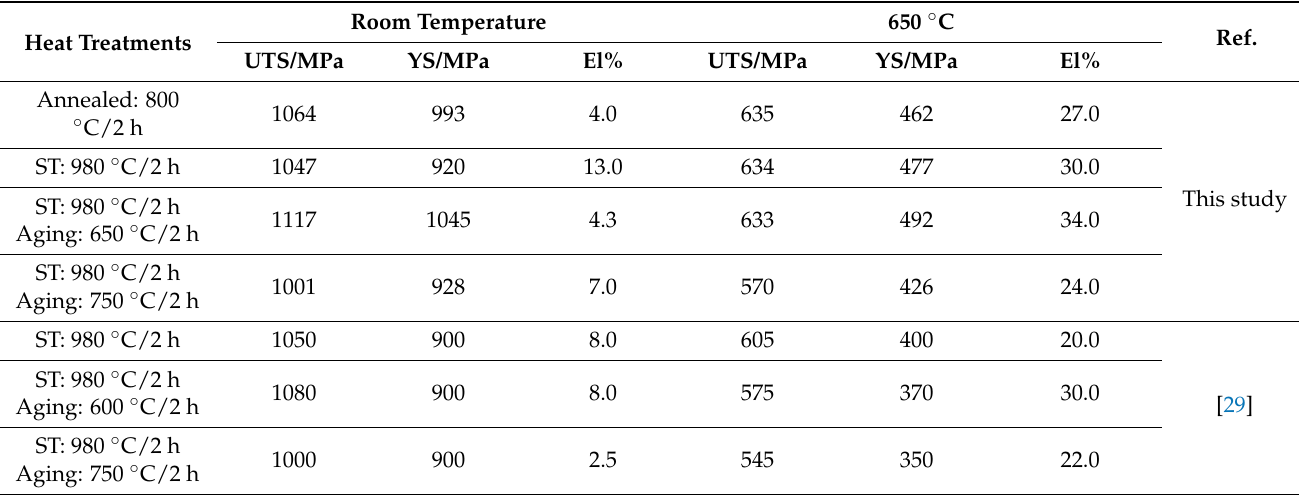
Table 2. Mechanical properties of TC31 fabricated by LMD and conventional technique at room temperature and 650 °C.